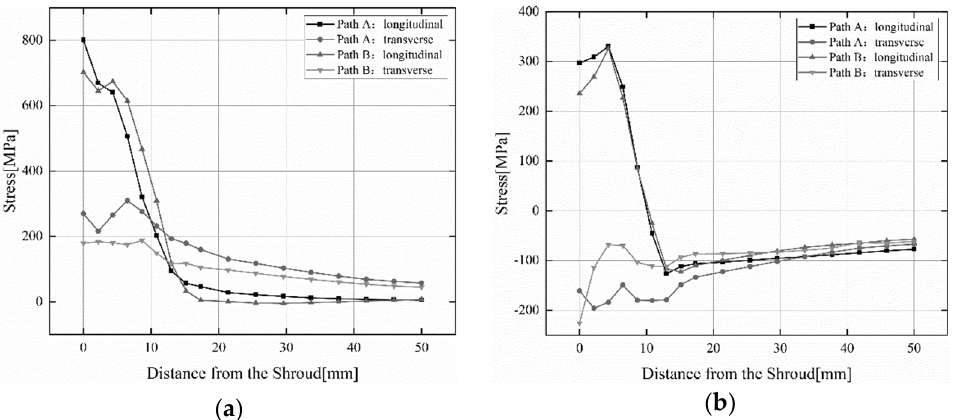
Figure 15. Residual stress distribution on the water outlet surface and water inlet surface of the blade with the same section. ( a ) water outlet surface; ( b ) water inlet surface.